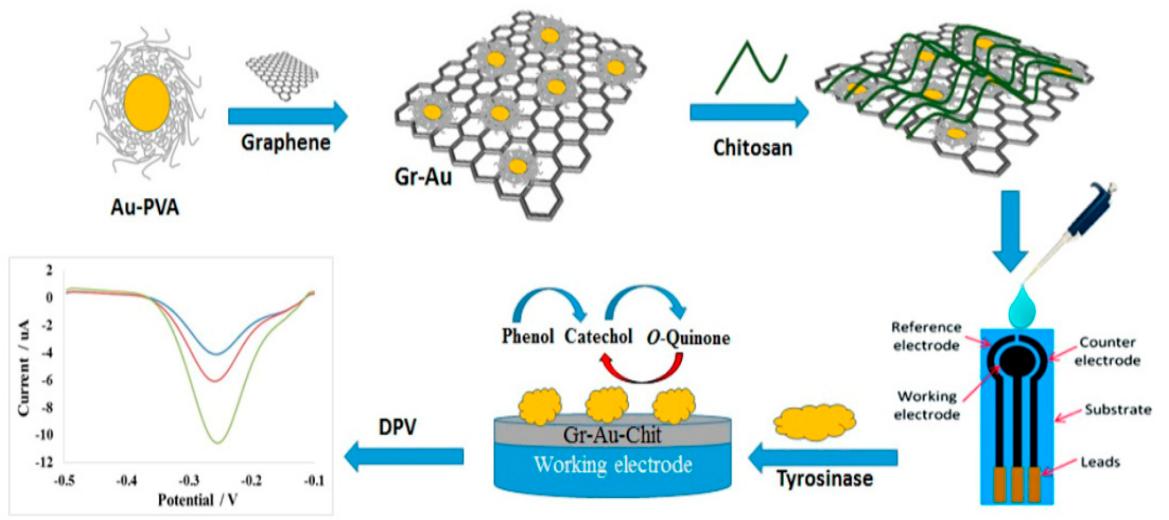
Figure 5. Construction of the electrochemical biosensor [113].